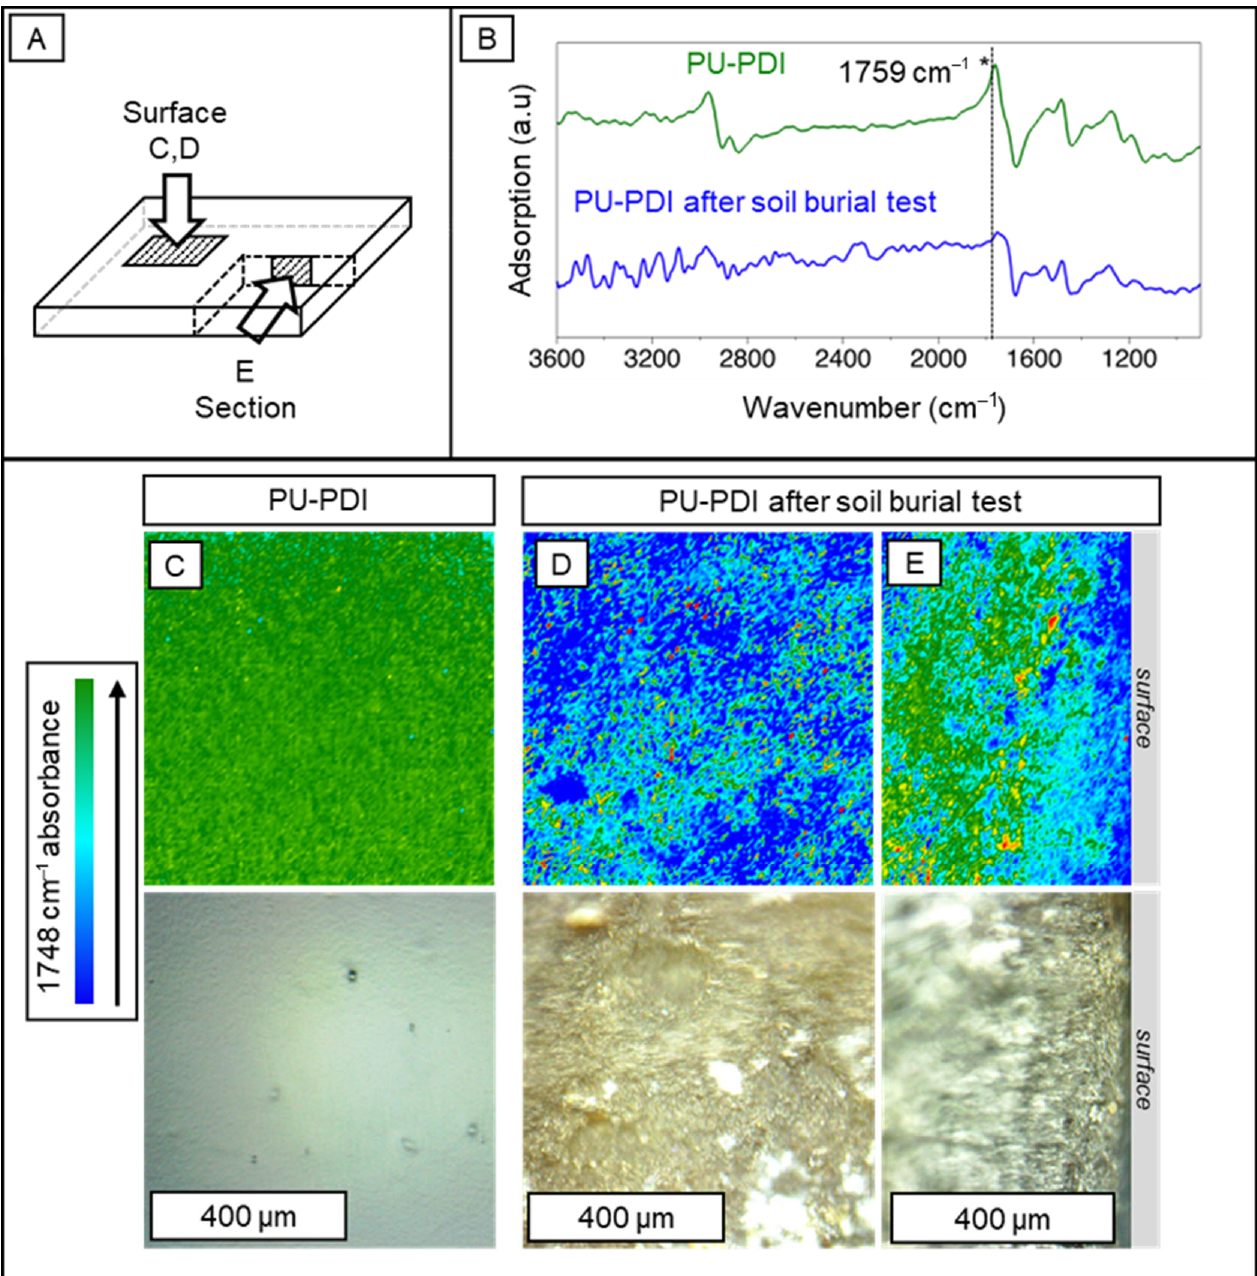
Figure 6. Panels ( A , B ) show the IR maps related to different portions of the analyzed polymer samples and the reflectance spectra, respectively. Two-dimensional FTIR imaging maps showing the intensity of the carbonyl group of the castor oil IR band at 1759 cm –1 (stretching, highlighted with a “*”) on the surface and across the section of PU-PDI, prior ( C ) and after ( D , E ) soil burial test, are presented. The band appeared as strong derivative shaped peak in the reflectance spectra ( B ); each spectrum was related to a pixel (5.5 × 5.5 µ m 2 ) of the maps. The positive part of the peak is imaged as green pixels in the false color IR maps, whereas the absence of the peak appears as light blue-blue pixels. ( C ) Surface map of PU-PDI. ( D , E ) Surface and section maps of the same sample after soil burial test. Each IR map refers to the visible image reported